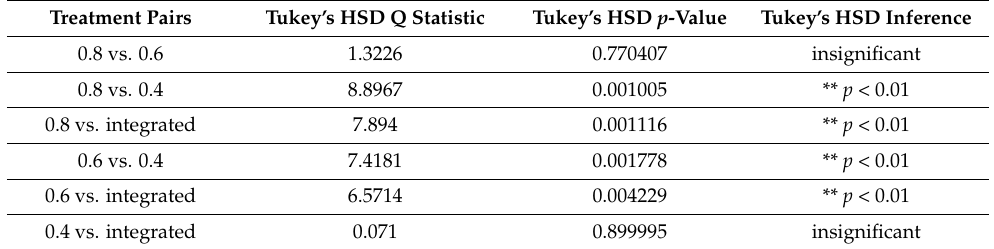
Table 7. Tukey’s honestly significant difference analysis results from ammonia datasets. Treatment Pairs